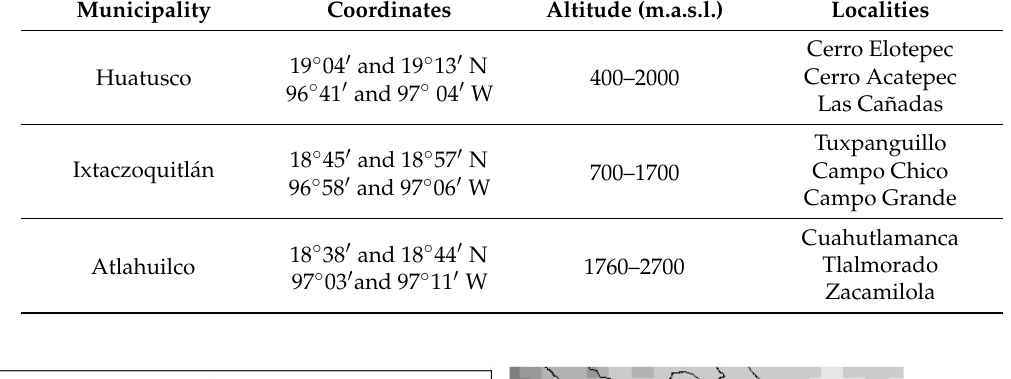
Table 1. Municipality and localities of the study area.